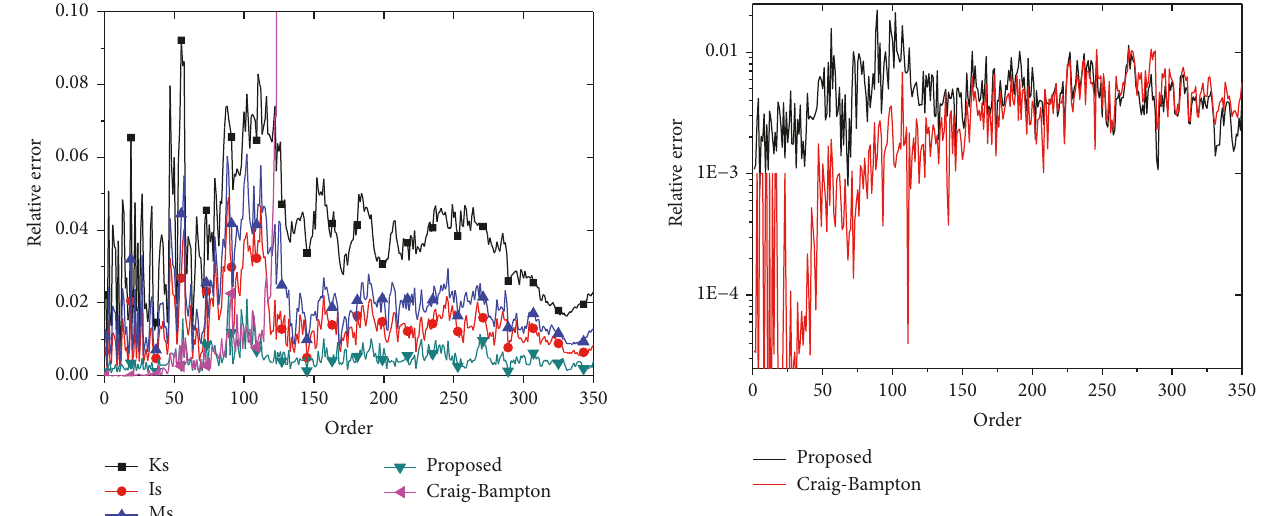
Figure 12: The convergence comparison between the proposed G s matrix and the Craig-Bampton method; 281 normal modes were kept for both methods for every